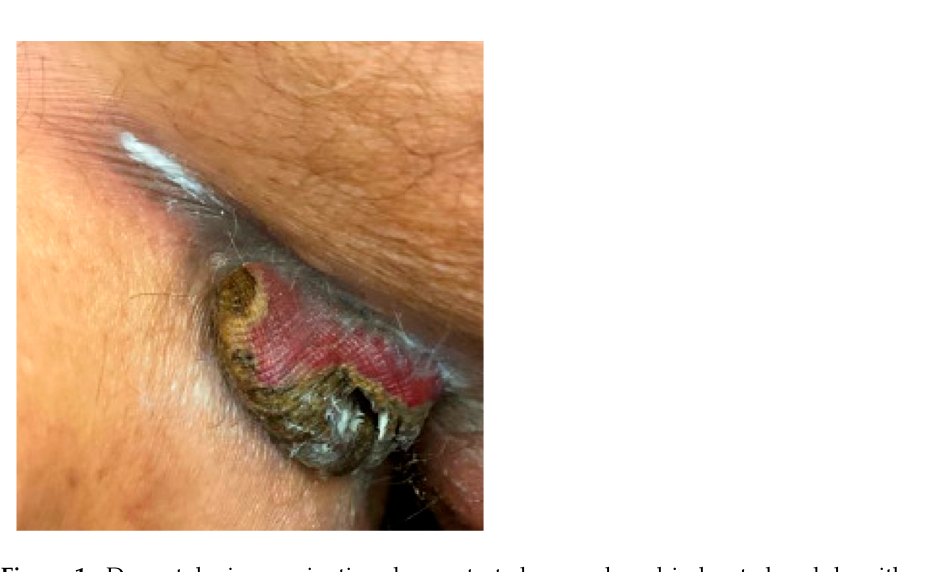
Figure 1. Dermatologic examination demonstrated a purple-red indurated nodule with central ulceration and yellow crust in the right groin.